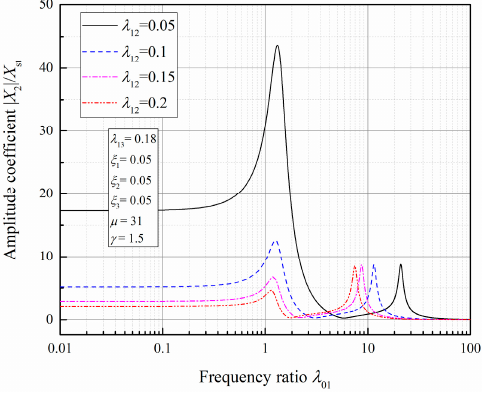
Figure 9. The dynamic response of the accessory structure with a varying parameter λ 12 ( λ 12 ≤ λ 13 = 0.2 ) .